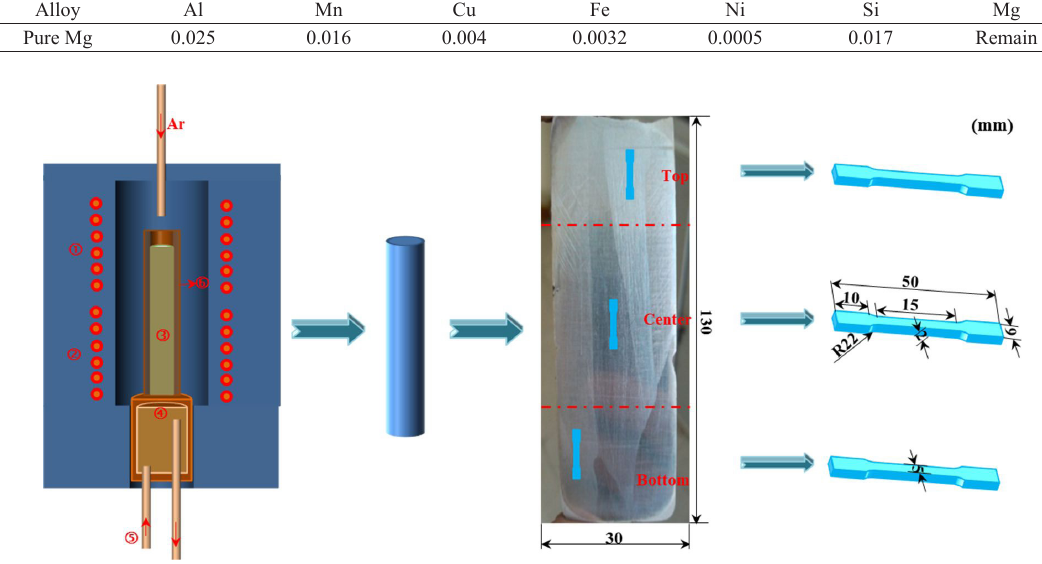
Table 1. Chemical composition of Pure Magnesium. ( wt. % )